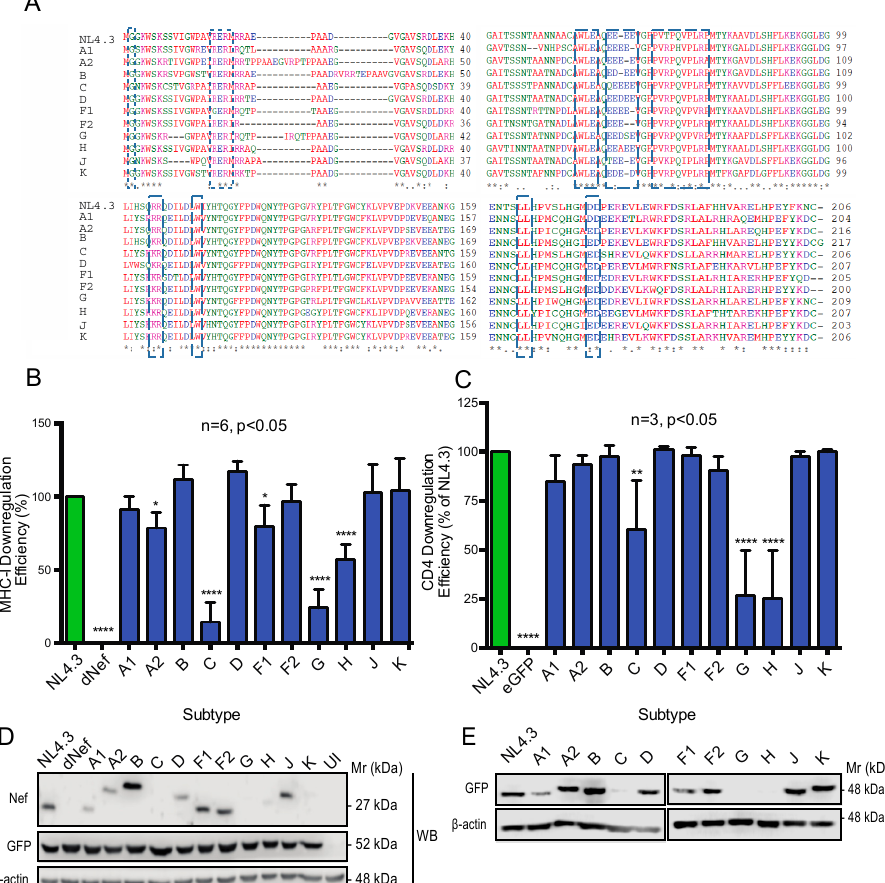
Figure 1. Nef from various human immunodeficiency virus type 1 (HIV-1) group-M subtype reference strains display differential expression and functionality. ( A ) Clustal Omega [39,40] was used to align Nef protein sequences from reference strains of group-M HIV-1 subtypes. * indicates identical residues, : indicates conserved residues, . indicates semiconserved residues. Residues in blue are acidic amino acids, residues in pink are basic amino acids, residues in red are small hydrophobic amino acids, and residues in green are hydroxyl, amine, or basic amino acids. Nef domains are boxed. ( B ) Isogenic NL4.3 dGag/Pol enhanced GFP (eGFP) pseudoviruses only differing in the nef gene from reference strains of group-M subtypes were used to infect Jurkat E6.1 T cells. Cell-surface major histocompatibility complex class I (MHC-I) levels were measured via flow cytometry 48 h post infection with a pan-specific anti-MHC-I primary antibody and an Alexa Fluor 647-conjugated secondary antibody. Downregulation efficiency is relative to NL4.3. ( C ) Plasmids encoding eGFP-tagged Nef proteins from reference strains of group-M subtypes were transfected into cluster of differentiation 4 (CD4) HeLa cells. Forty-eight hours post transfection, cell-surface CD4 levels were quantified via flow cytometry using an allophycocyanin (APC)-conjugated anti-CD4 antibody and measured using flow cytometry. Downregulation efficiency is relative to NL4.3. ( D ) Jurkat E6.1 T cells were infected with isogenic pNL4.3 dGag/Pol eGFP pseudoviruses only differing in the nef gene. Forty-eight hours post infection, cells were lysed and immunoblots were conducted to detect Nef expression. ( E ) Plasmids encoding Nef–eGFP fusion proteins were transfected into CD4 HeLa cells. Forty-eight hours post transfection cells were lysed, and immunoblots were conducted. A mouse anti-actin primary antibody was used to validate equal loading of protein. (UI: uninfected; dNef: pseudovirus deficient in nef ; Mr: molecular weight; * p ≤ 0.05; ** p ≤ 0.01; **** p ≤ 0.0001).